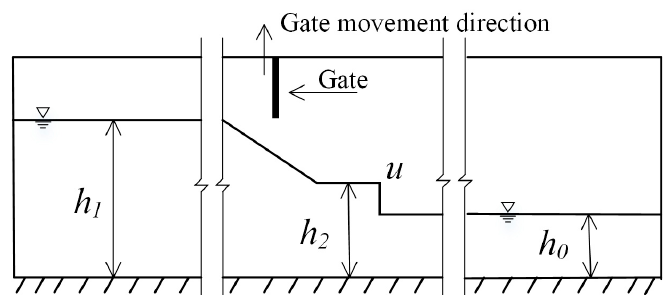
Figure 4. Sketch of the empty wave fl ume.